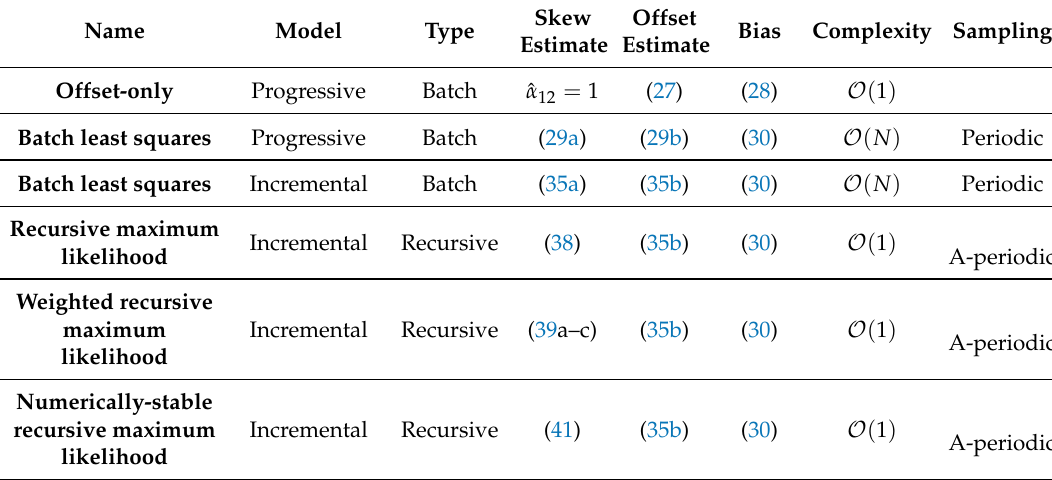
Table 7. Comparison of clock discipline